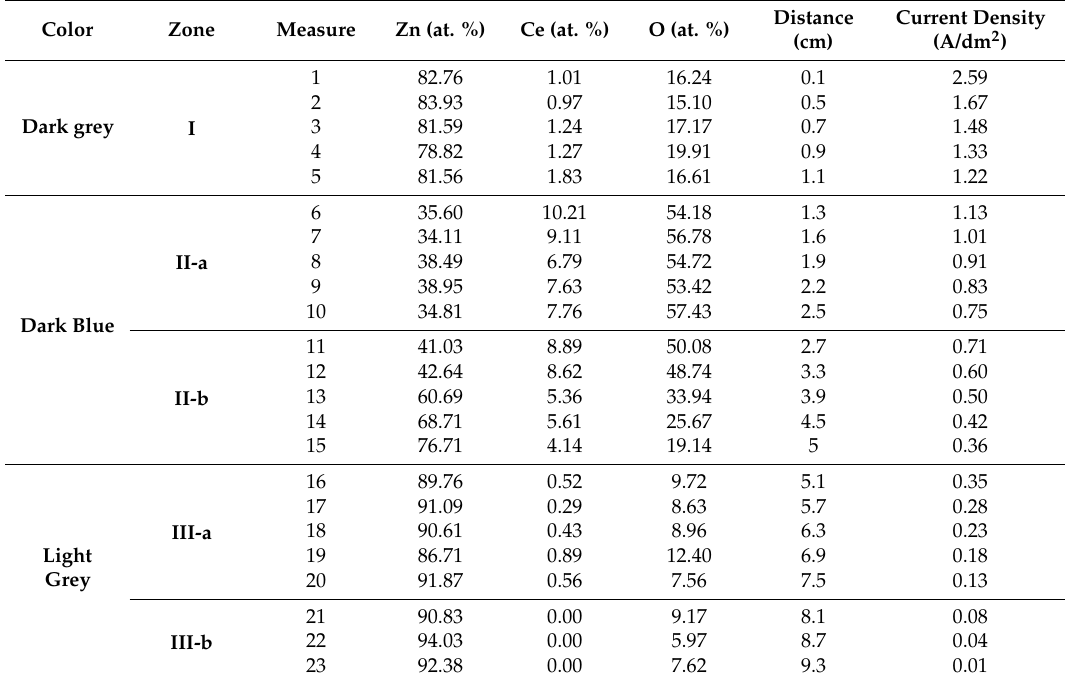
Table 1. Surface chemical composition of the electrodeposit obtained by EDX as a function of the current density for each zone. Color Zone Measure Zn (at. %) Ce (at. %) O (at. %)